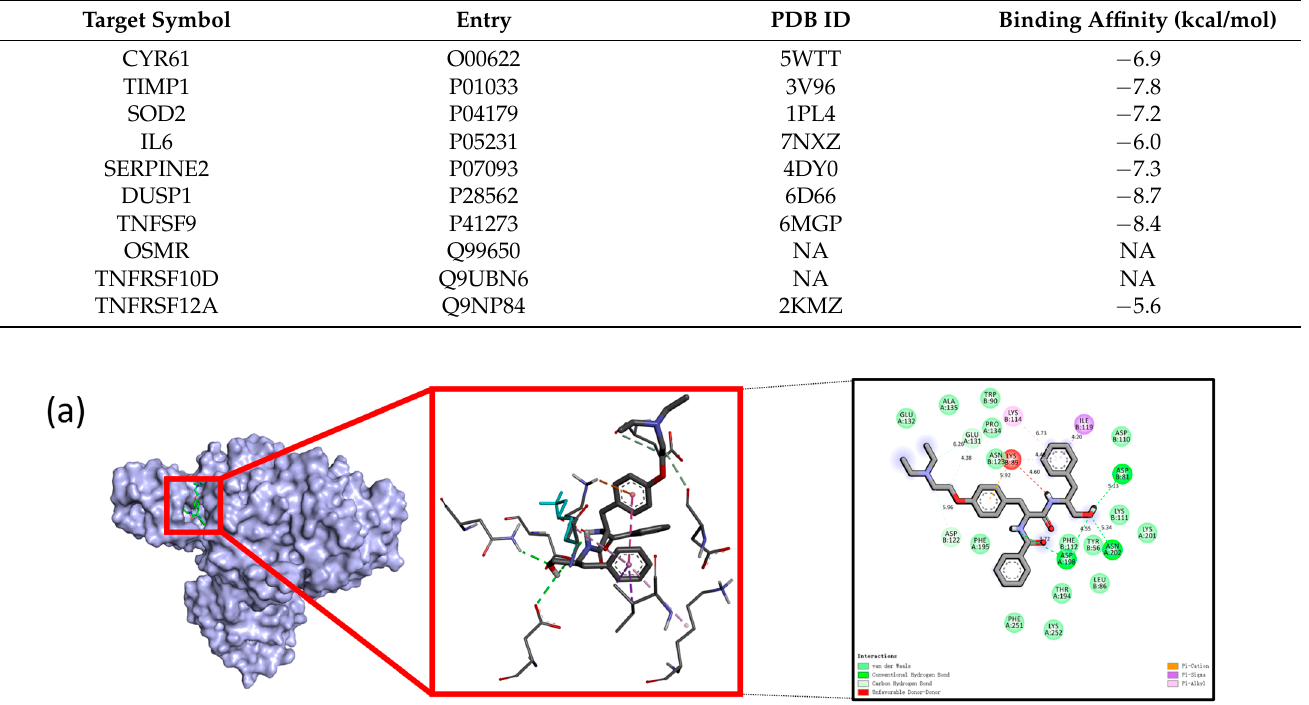
Figure 7. Validation of the two targets of HXL131 regulation, DUSP1, and TNFSF9. ( a ) Molecular docking visualization model of small-molecule ligand (compound HXL131) with the protein recep- tor (DUSP1). This compound formed hydrogen bonds with ASP A: 198, ASP B: 81, and ASN A: 202 amino acid residues site; ( b ) Molecular docking visualization model of the small-molecule ligand (compound HXL131) with the protein receptor (TNFSF9). The compound formed hydrogen bonds with HIS C: 205, ARG C: 202, and GLY A: 231 amino acid residue site; ( c ) The Odyssey infrared imaging system shows a band map; ( d ) Statistical plots of the relative expression of DUSP1 and TNFSF9 proteins. The targeted binding ability of HXL131 to target the DUSP1 and TNFSF9 proteins was verified by ( c , d ) when we were using a cellular thermal shift assay (CETSA). Values are mean ± SD ( n = 3). * p < 0.05, ** p < 0.01, *** p < 0.001 vs. Control (DMSO) group; n.s, non-significant. Multiple t -tests and two-way ANOVA were used for statistical analysis. 2.6.4. CETSA Verified the Targeted Binding of HXL131 to DUSP1 and TNFSF9 in Molecular Docking When a target protein binds to a drug molecule, it usually becomes stable and less susceptible to thermal denaturation. This change can be seen in the cellular thermal shift assay (CETSA) results. Therefore, the DUSP1 and TNFSF9 target proteins with a low bind- ing energy were selected for the CETSA analysis. The results showed that (Figure 7c,d) when they were compared with those of the control (DMSO), the protein expression levels of DUSP1 and TNFSF9 were significantly increased. Still, the expression levels of DUSP1